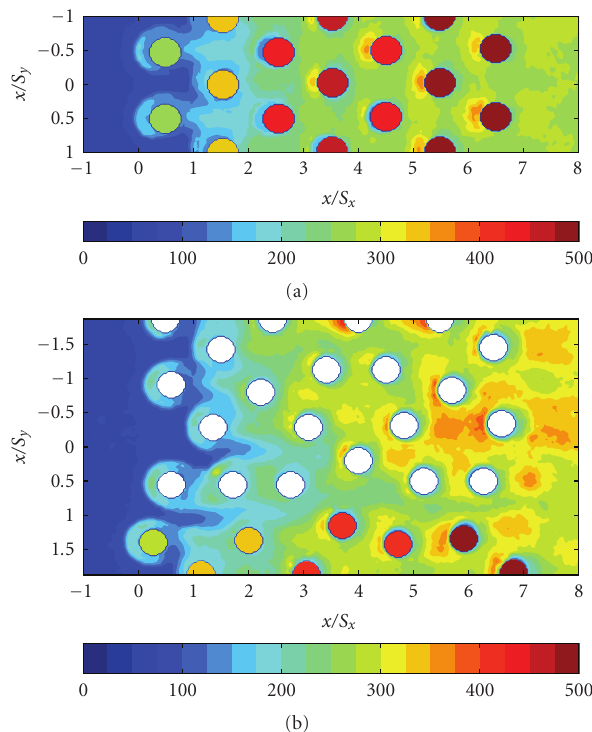
Figure 9: G 2.5 and G 2.6 endwall HTC [W / m 2 K] map—Re d 7 = 18000.